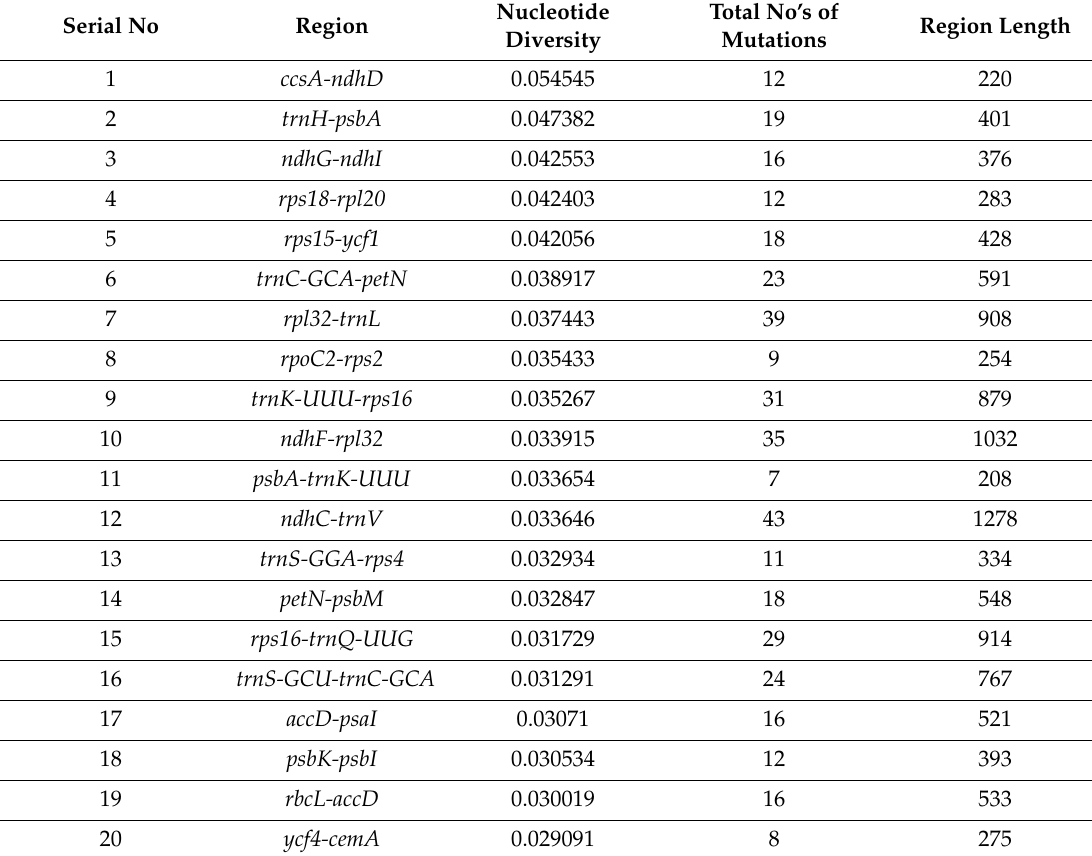
Table 5. Mutational hotspots in the genus Artemisia